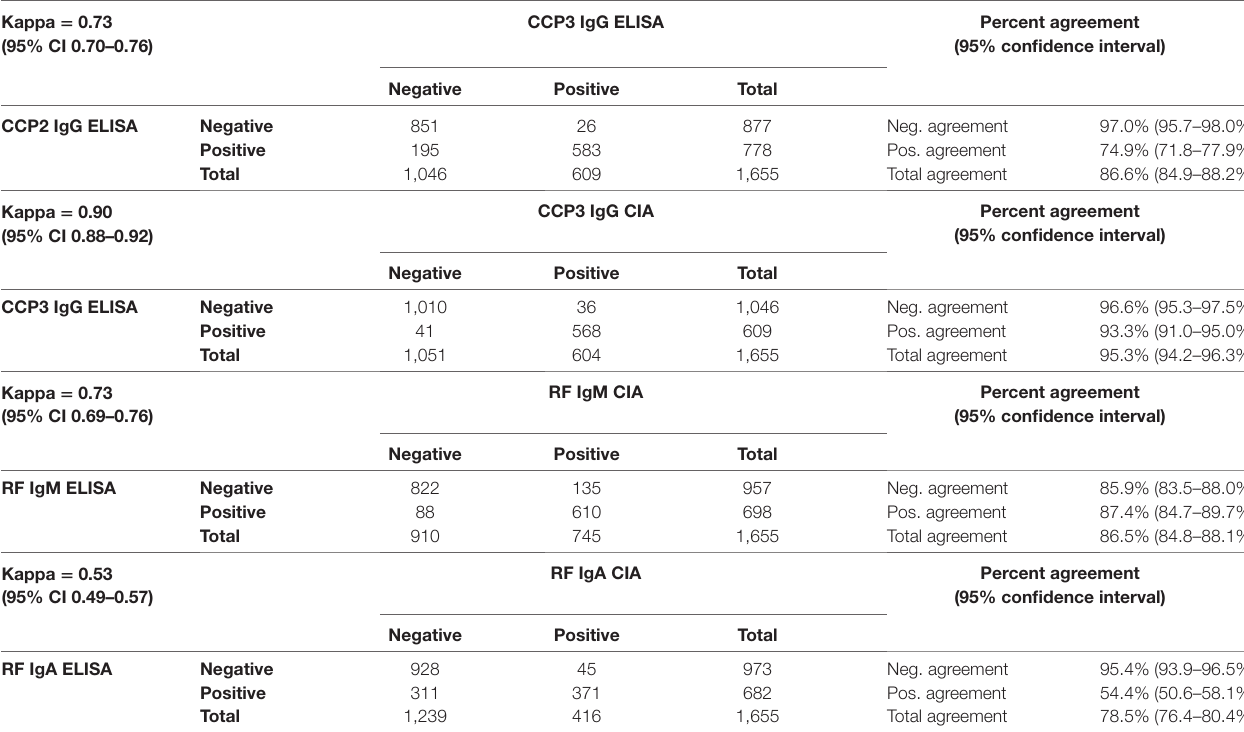
TaBle 3 | Agreement between the CCP2 and CCP3 ELISA assays (A), and between ELISA and CIA for CCP3 (B), RF IgM (C) and RF IgA (D). Kappa = 0.73 (95% ci